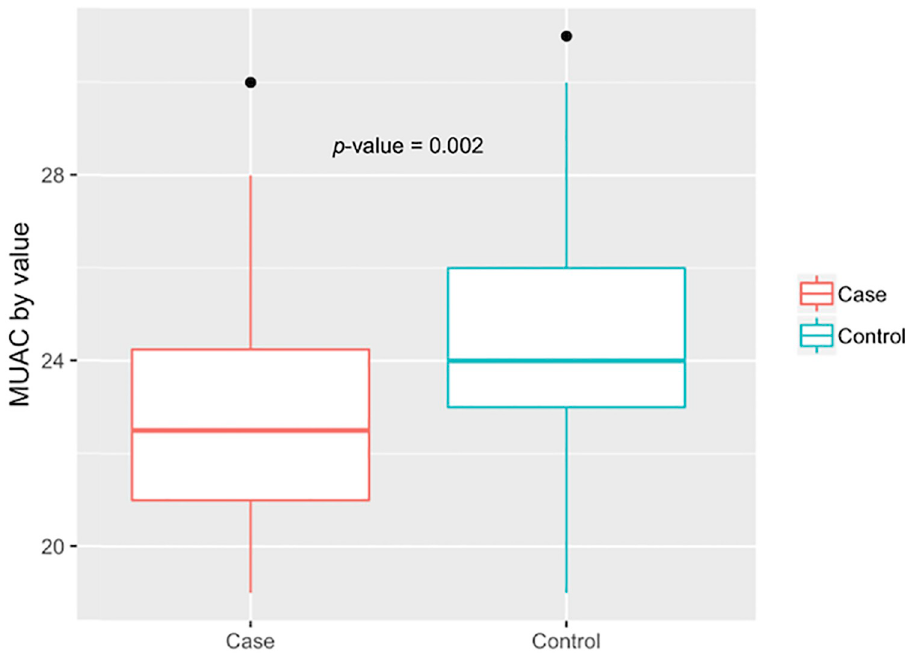
Fig 2. Comparison of mean MUAC (cm) between cases and